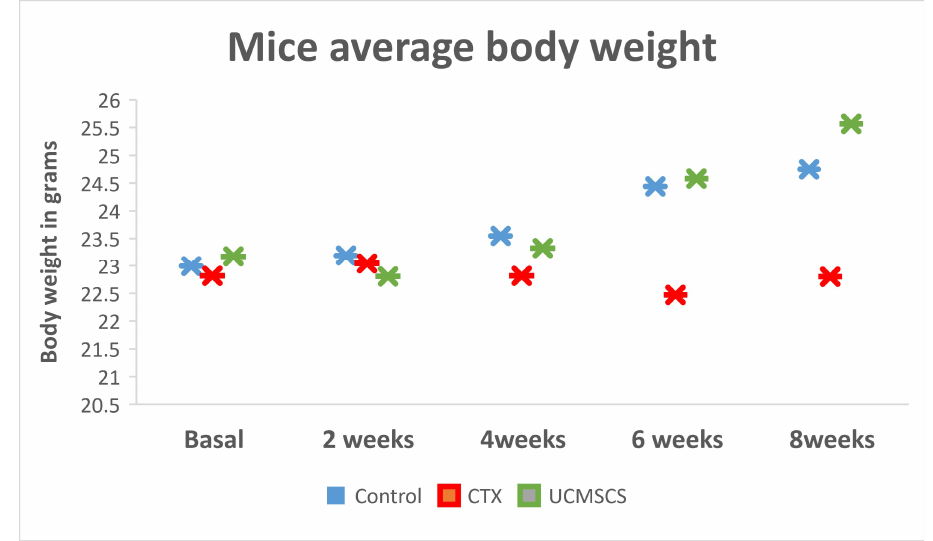
Figure 2. The diagram is showing the trend for increase in body weight in the stem cells group in comparison to significant decrease in the combination chemotherapy (CTX) group.